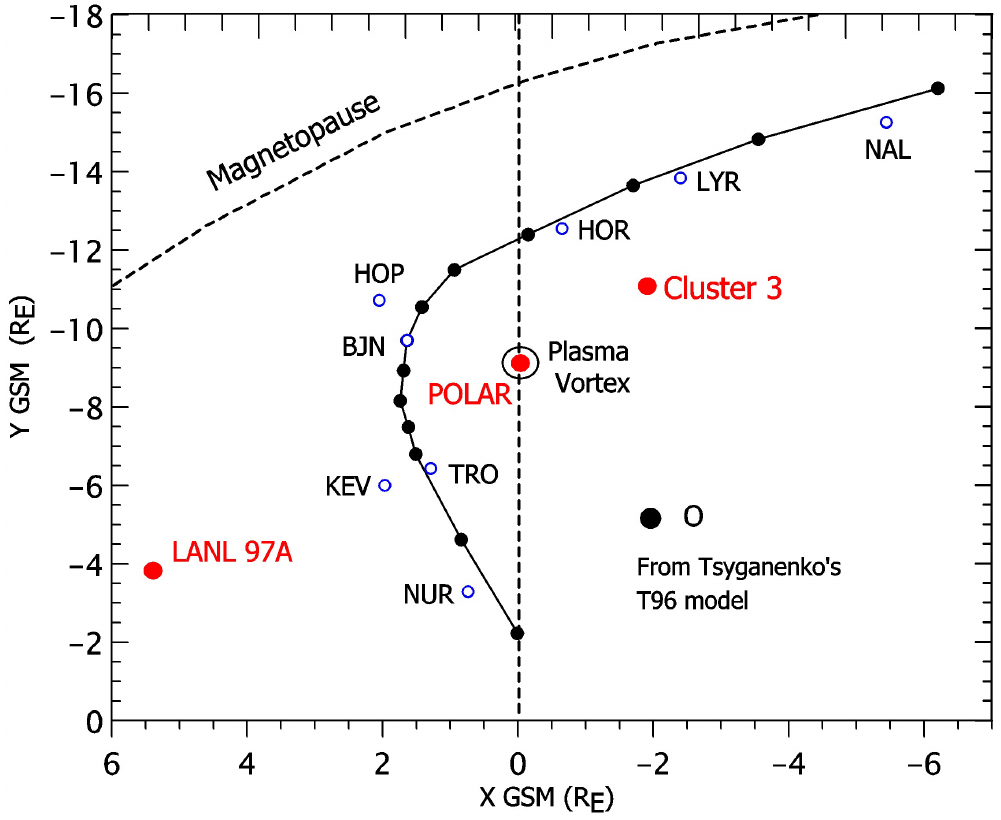
Fig. 1. The positions of the Cluster 3, POLAR and LANL 97A satellites projected over the XY GSM plane are shown, along with the eight conjugate points of the ground stations NAL, LYR, HOR, HOP, BJN, TRO, KEV and NUR over the equatorial plane (open circles). The solid circle symbols correspond to a hypothetic chain of ground stations having progressively increasing latitudes, while their longitude is 19.2 ◦ (i.e. the BJN